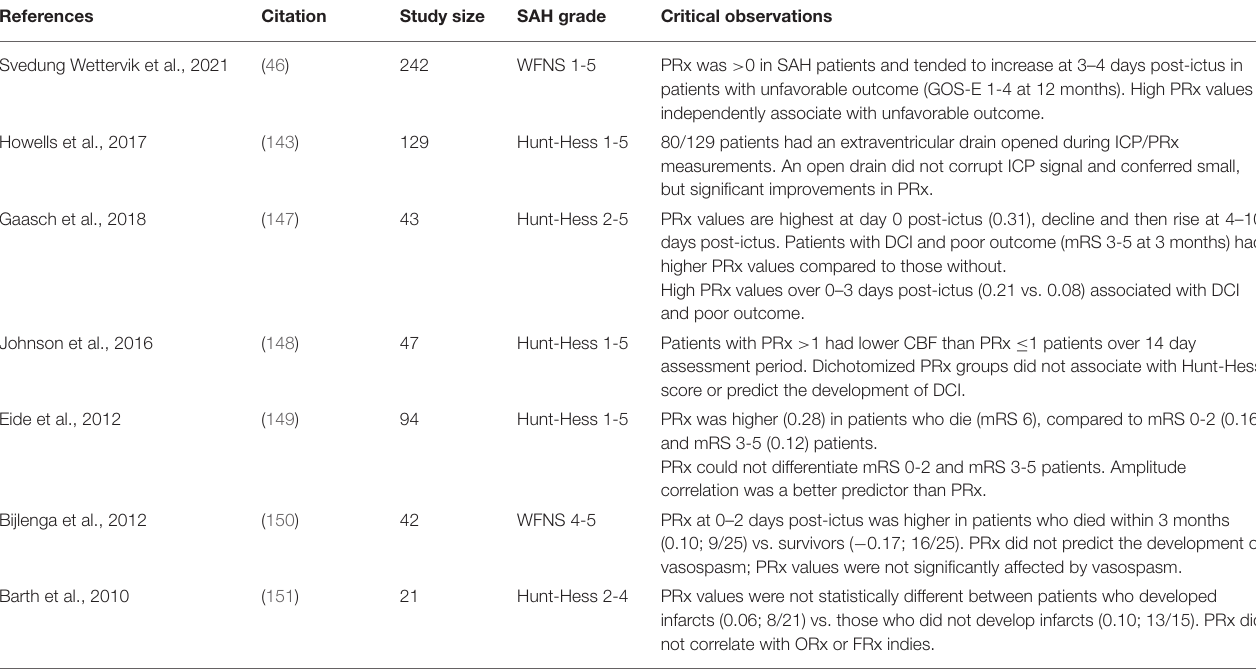
TABLE 4 | Clinical studies utilizing Pressure Reactivity Index (PRx) measurements in subarachnoid hemorrhage